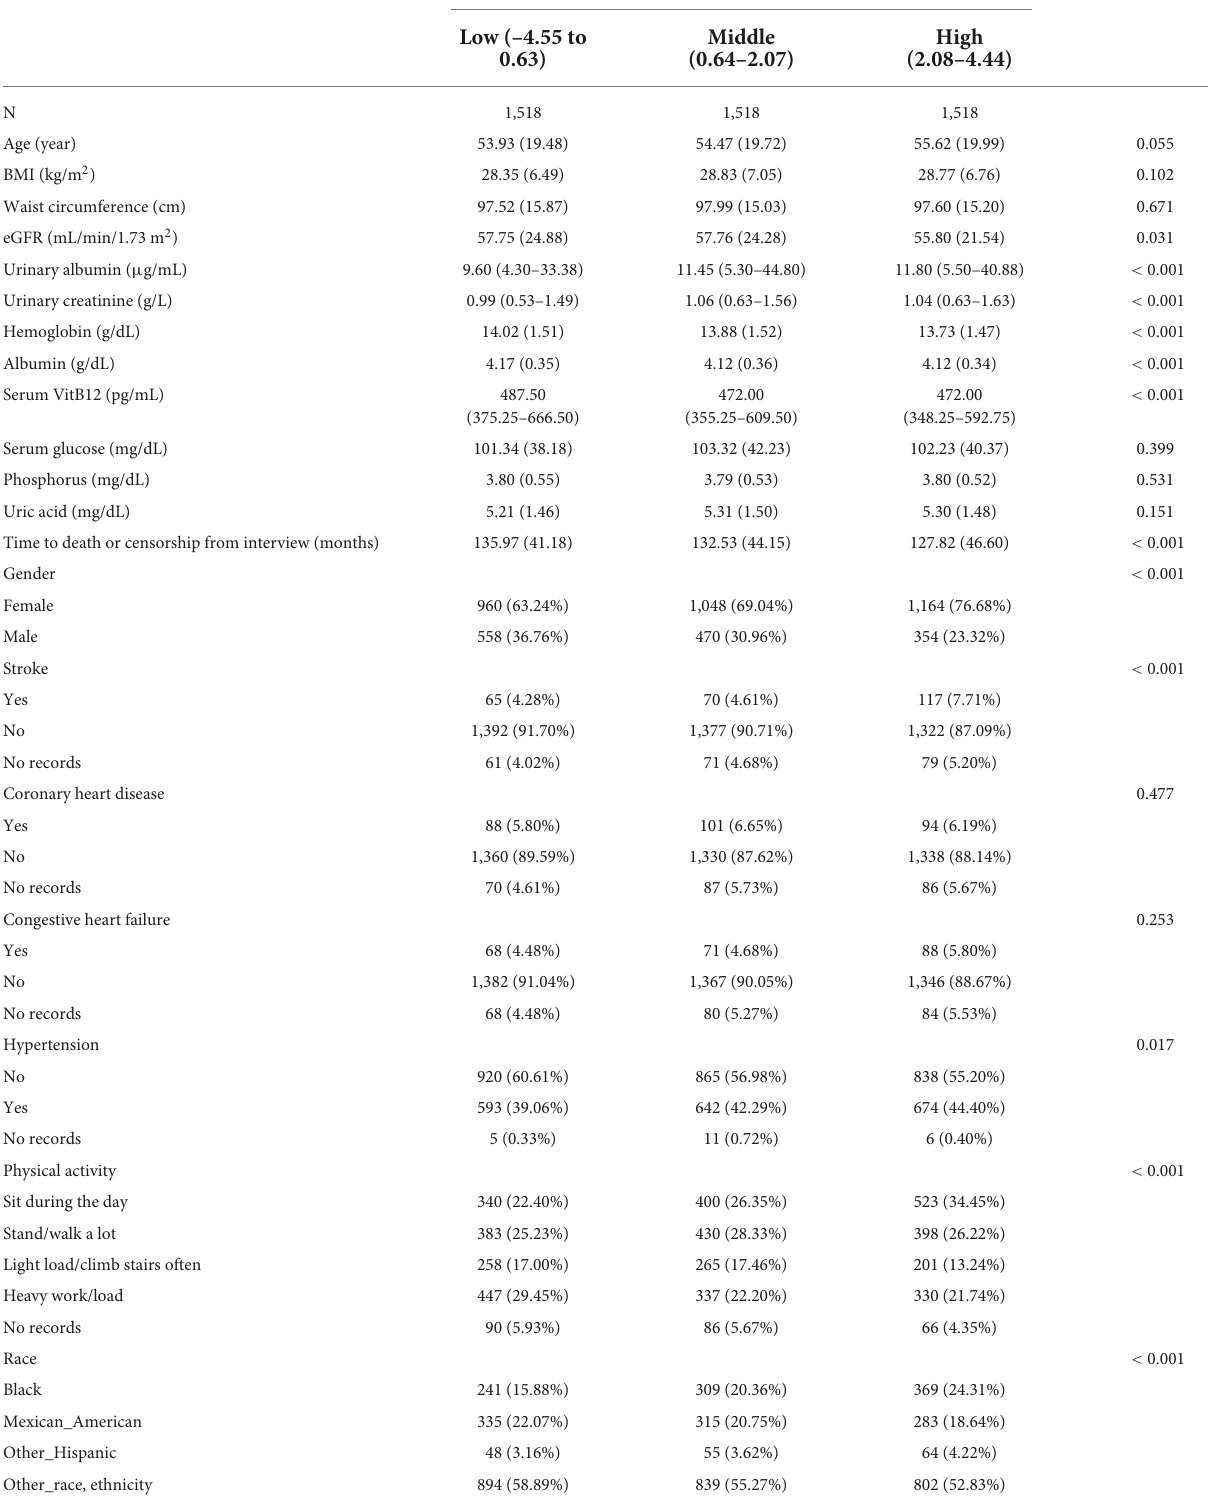
TABLE 1 Baseline characteristics of the study participants with chronic kidney disease (CKD) ( n = 4,554).